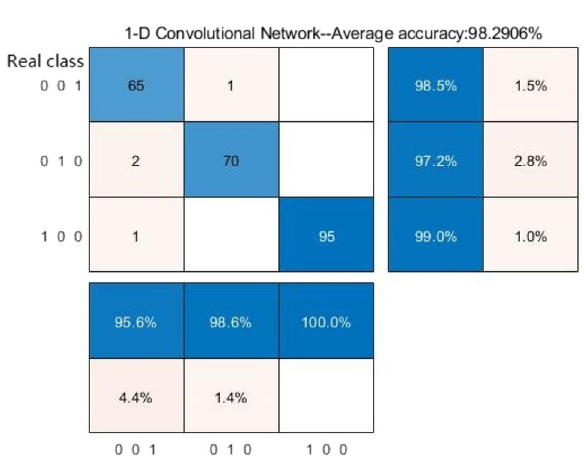
Figure 5. Multi-period, EPNCC feature classification confusion matrix.